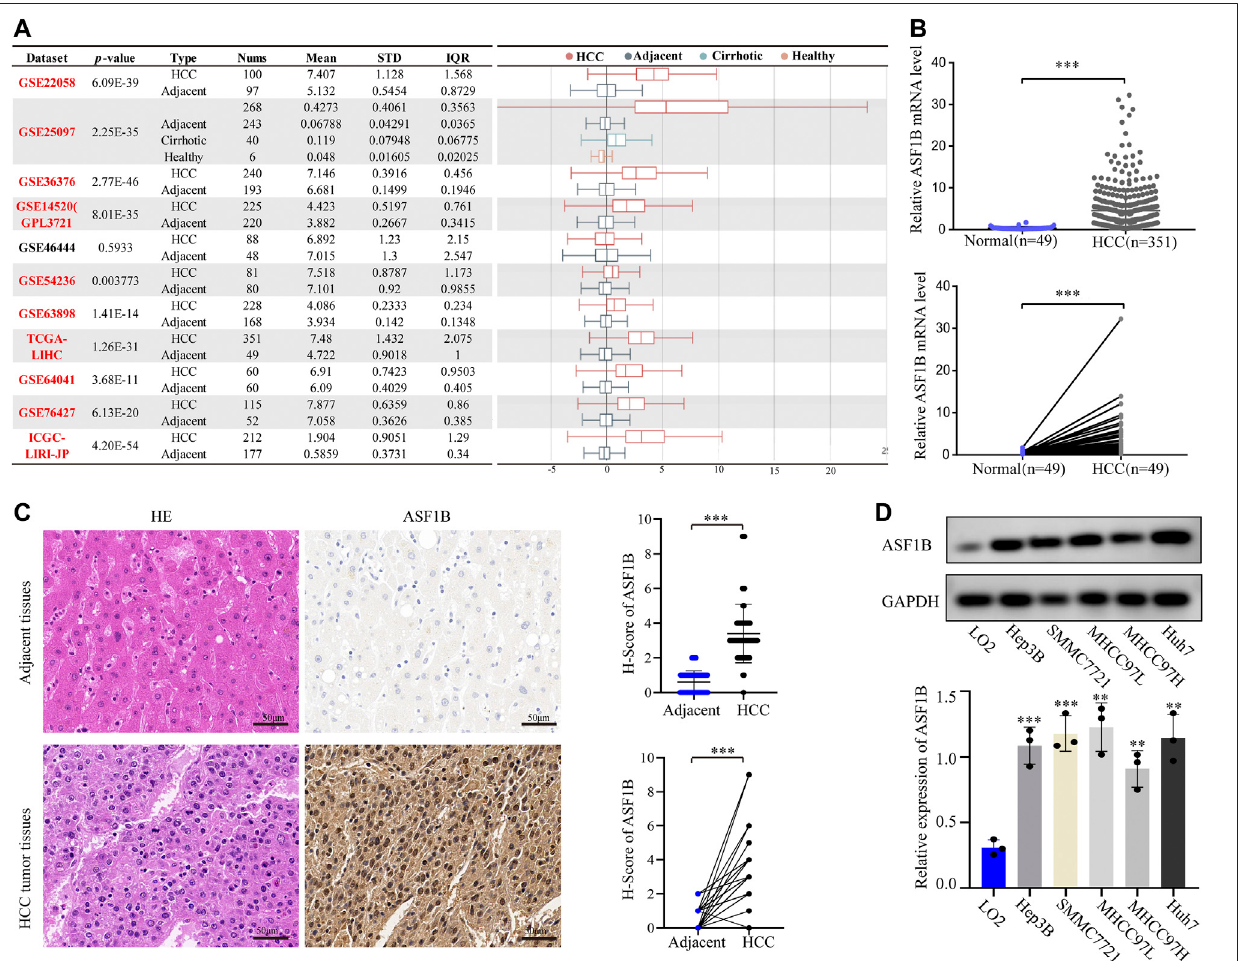
FIGURE2| ASF1BmRNAandproteinexpressioninHCC. (A) ChartandplotofASF1BexpressioninHCCandmatchedadjacentnoncanceroustissuesbasedon HCCDB database; (B) Signi fi cant differences of ASF1B mRNA level in HCC and the adjacent noncancerous tissues in TCGA database; (C) HE images of HCC tumor tissues and adjacent noncancerous tissues (left); IHC images and H-score of the ASF1B proteins expression in HCC tumor tissues and adjacent noncancerous tissues (right). Magni fi cation = ×400. The positive staining appears brown; (D) The protein expression of ASF1B in normal liver cell and HCC cells by western blot. ** p < 0.01; *** p <